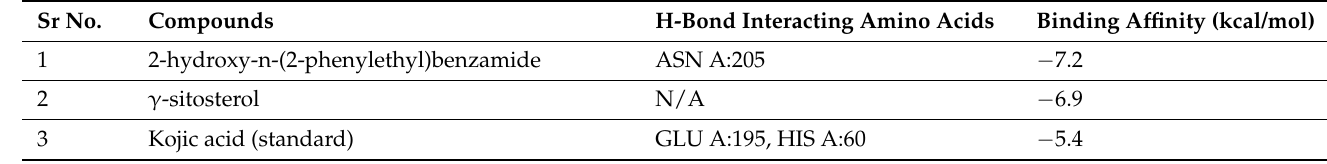
Table 8. Binding affinity of GC–MS compounds and bond interaction with tyrosinase.